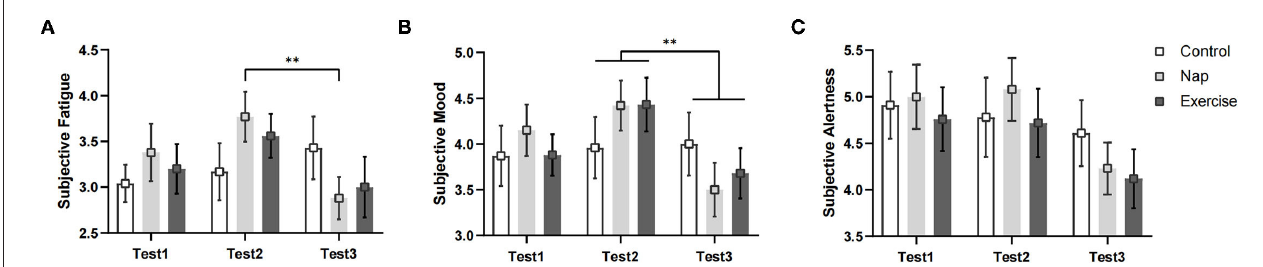
FIGURE 3 | Subjective states. (A) Subjective fatigue; (B) subjective mood; (C) subjective alertness. Error bars represent one standard error of the mean. ** p <